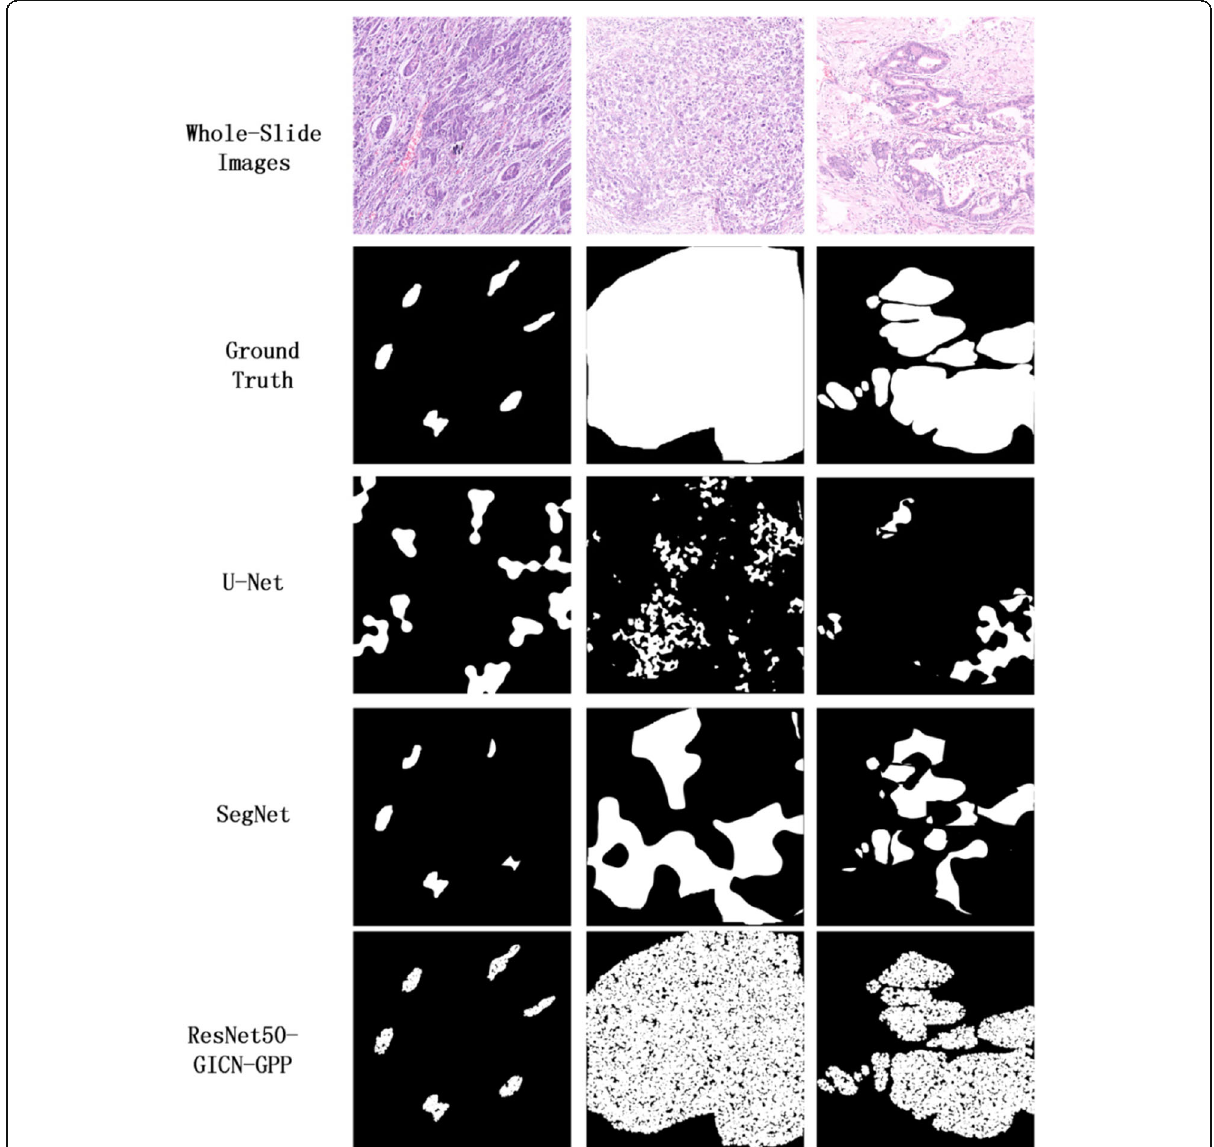
Fig. 3 Comparison of U-Net, SegNet and ResNet50-GICN-GPP segmentation results